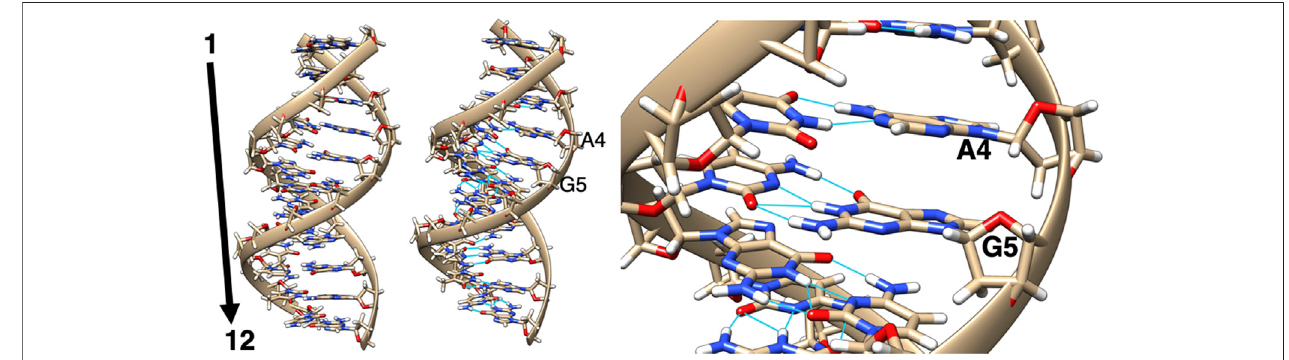
FIGURE2| Twoviews ofthe minimized structure(left and middle) ofthe unaltered DNA dodecamer with asequence of5 ′ -D(-GP-AP-GP-AP-GP-CP-GP-CP-TP- CP-TP-C)-3 ′ , with the 5th G residue (zoomed in, right) being modi fi ed in the adduct formation.